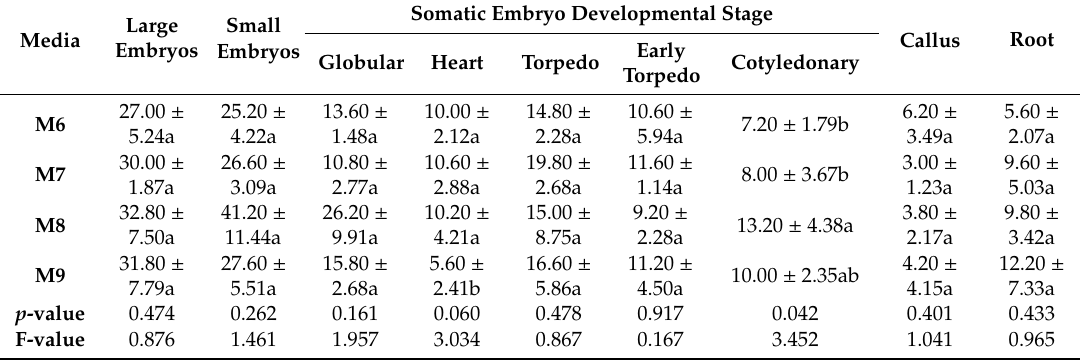
Table 3. Comparison of embryo size classes, somatic embryo developmental stage, number of SEs with callus formation at the base, and number of SEs that formed roots in M6-M9 medium after 8 weeks of subculture. All values are means ±